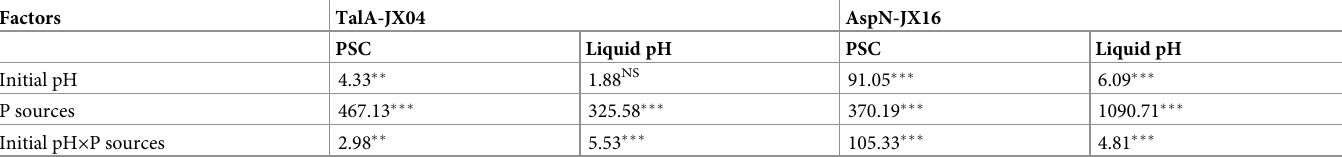
Table 4. The F -values of ANOVA for the effects of initial pH and P sources on phosphate-solubilizing capacity and pH after incubation of TalA-JX04 and